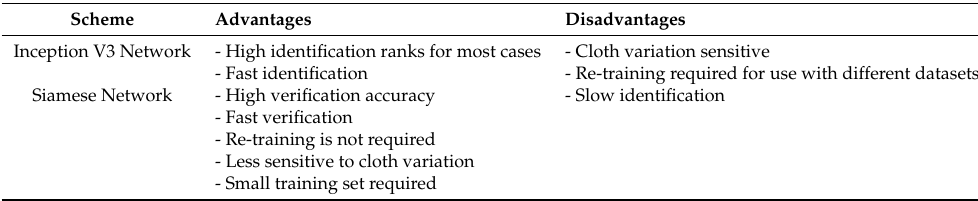
Table 11. Advantages and disadvantages of the two proposed